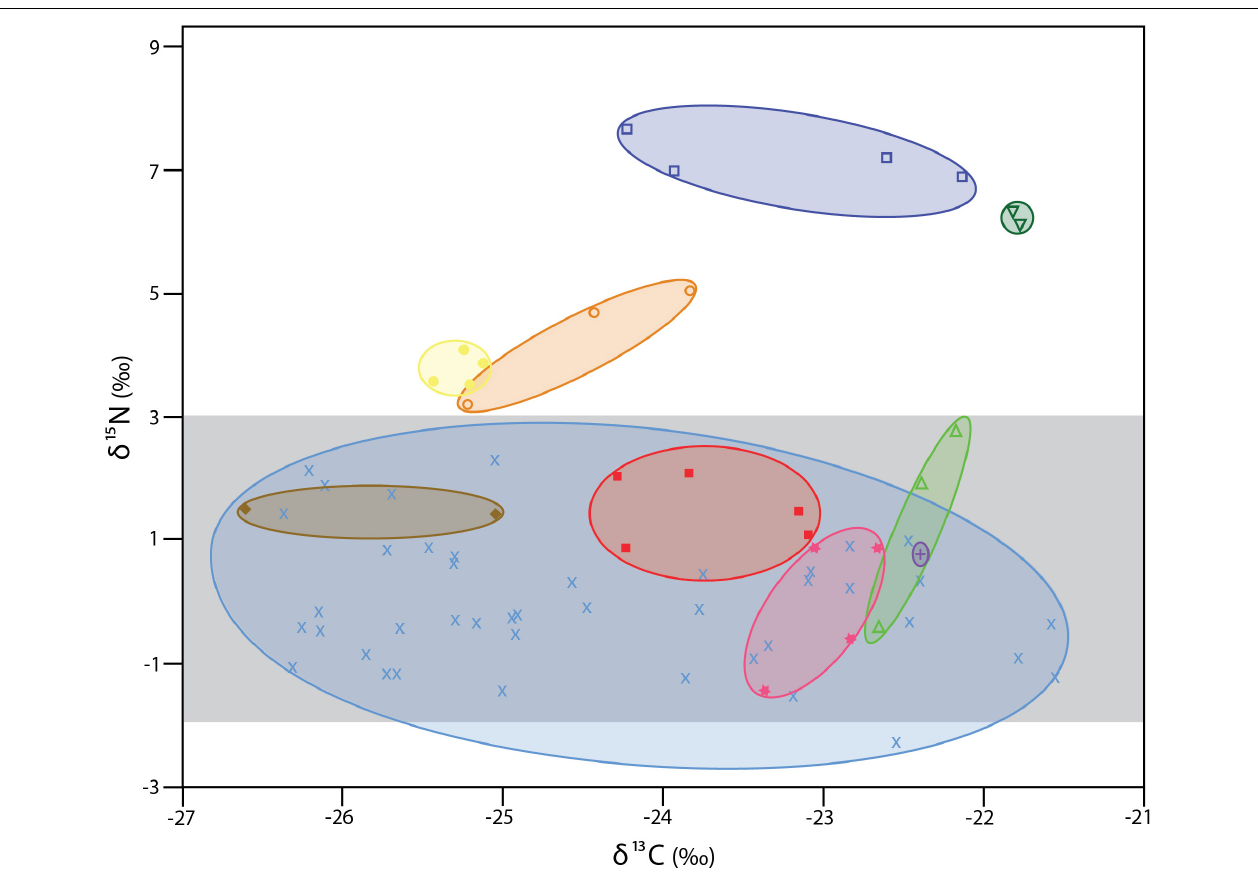
FIGURE 1 | δ 13 C and δ 15 N values for specimens analyzed here. Ovals unite species. All members of the X. dorsalis clade are represented by open symbols. Dark blue open squares X. washingtona ; dark green open, upside-down triangles X. dorsalis ; orange open circles X. alexisi ; green open triangles X. oregona . Yellow solid circles A. heterosiphon ; brown solid diamonds Xylopholas crooki ; red solid squares Xylophaga s.l. muraokai ; pink solid stars Xylophaga s.l. microchira ; purple plus sign Xyloredo nooi ; blue crosses Xylophaga s.l. zierenbergi from six pooled collections (for details see Table 1 ). The area highlighted in light gray is that consistent with nitrogen fixed by bacteria (–2 to +